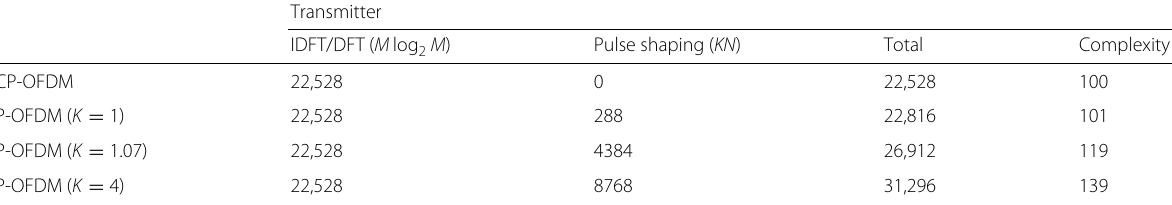
Table 7 Number of multiplications for pulse-shaped OFDM (FFT size M = 2048, TF = 1.07)